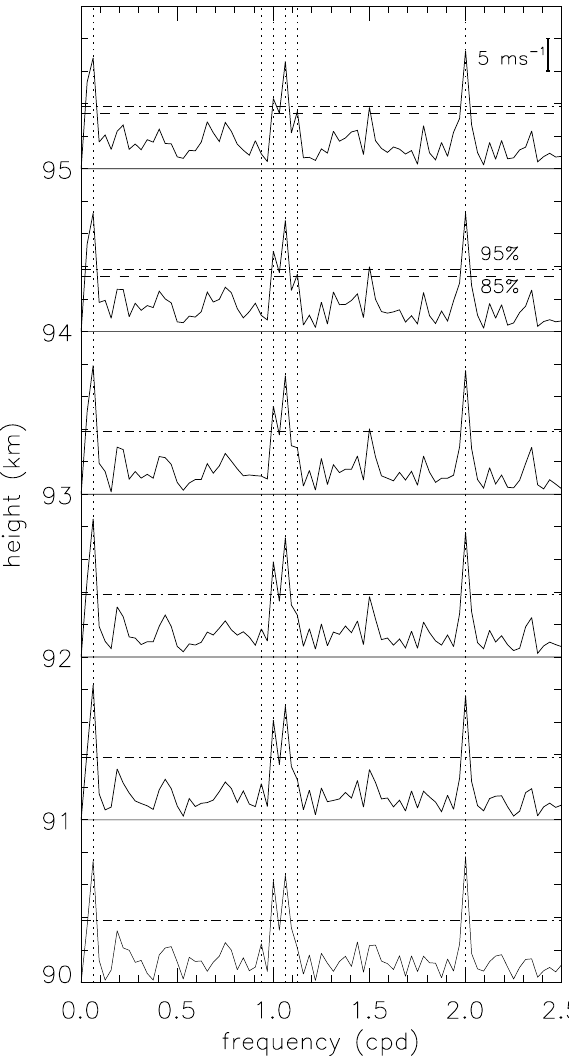
Fig. 5. Fourier spectra of meridional wind during 32 days. The dot- ted vertical lines from left to right denote spectral components of 0.0625, 0.9375, 1.0, 1.0625 and 1.125cpd corresponding to periods of 16 days, 25.6, 24, 22.59, 21.33 and 12h, respectively. The dash- dotted and dashed (upper two panels) horizontal lines indicate the confidence levels of 95 and 85%,